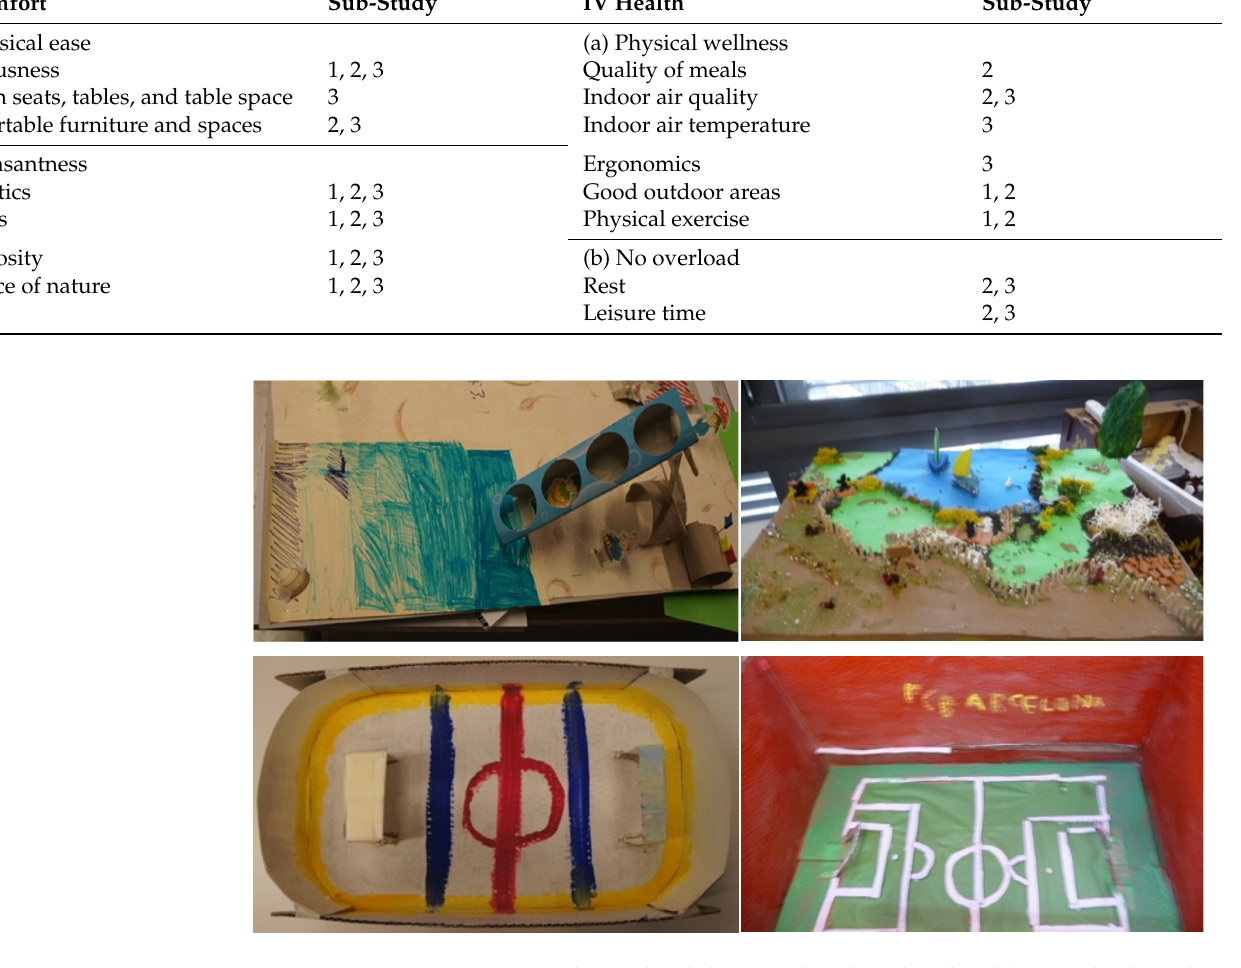
Figure 4. Learning environment design details by Finnish 2nd graders (beach), Spanish 8th graders (park), Finnish 6th graders (ice hockey rink), and Spanish 3rd graders (football stadium).